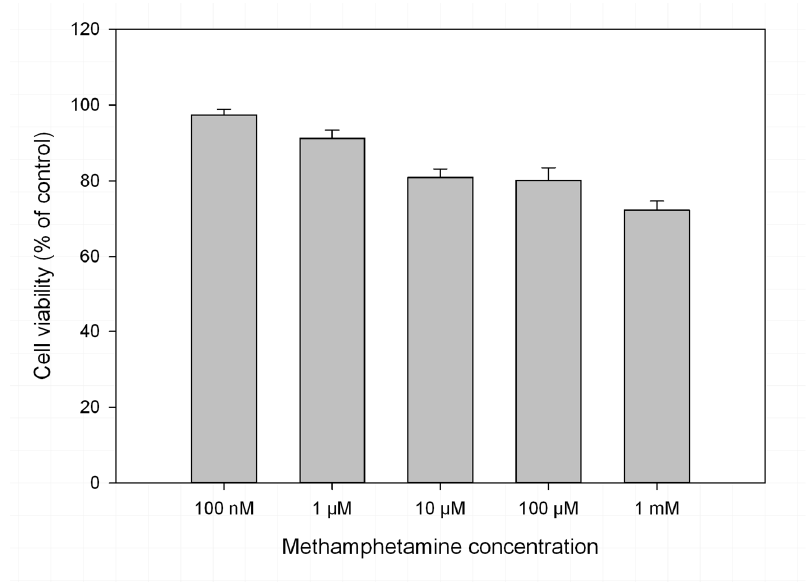
Figure 1. Cell viability of rat B50 neuroblastoma cells untreated or treated for 48 h with methamphetamine at 100 nM, 1 μM, 10 μM, 100 μM and 1 mM, determined using cell count with Trypan Blue exclusion. n = 3 for all conditions and error bars are SEM.